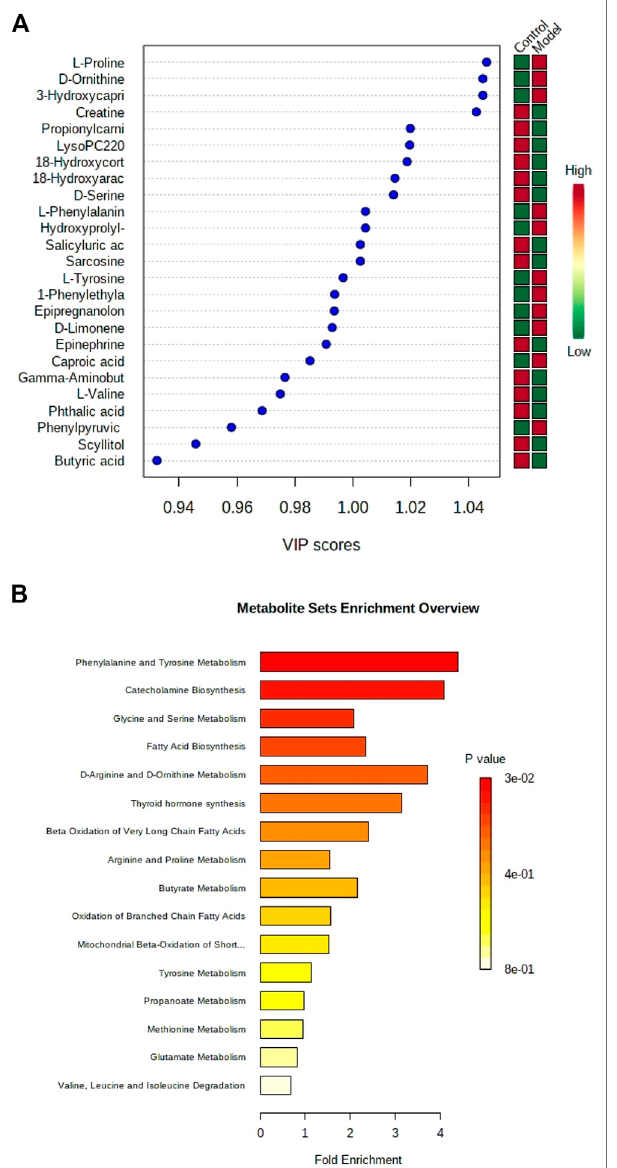
FIGURE2| VIPplotoflipidbiomarkercandidatesscannedbyOPLS-DA analysis using metabolomics method based on liquid chromatography coupled with mass spectrometry (A) . Enrichment analysis of potential lipid metabolites in control group and model group using metabolomics method based on liquid chromatography coupled with mass spectrometry (B) .